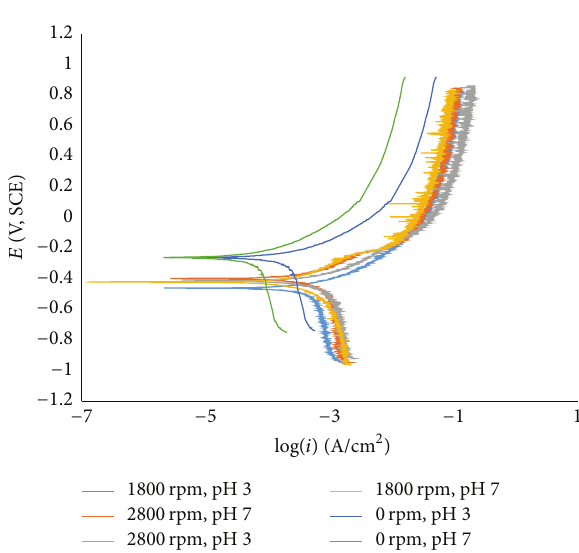
Figure 4: Potentiodynamic polarization curves of AISI 4330 steel electrodeatthevariouspHsolutionsandrotatingspeedsinsolutions containing 3 wt.% NaCl with a constant concentration of 10wt.% silica particles (105 𝜇 m).